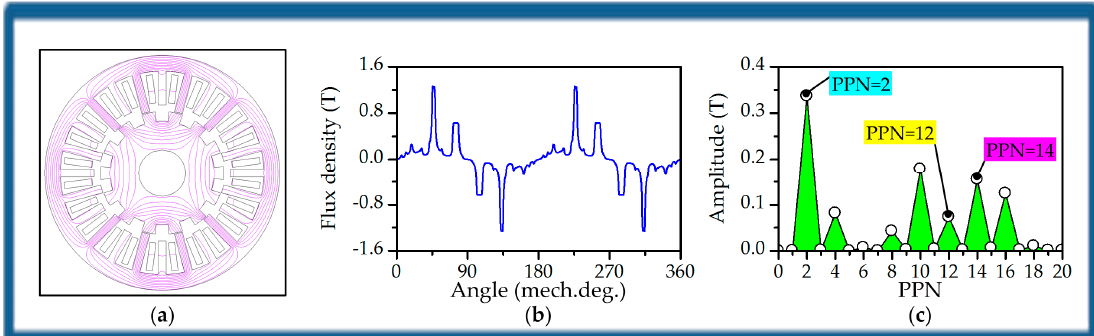
Figure 9. Analysis of magnetic field excited only by armature windings: ( a ) Flux lines distribution; ( b ) Flux density in the air-gap; and ( c ) Harmonic spectrum.